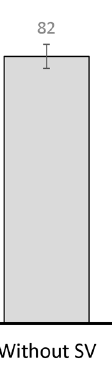
Figure 6. PRoPHET’s throughput (in %) without summary vector exchange and with summary vector exchange in the small scenario.